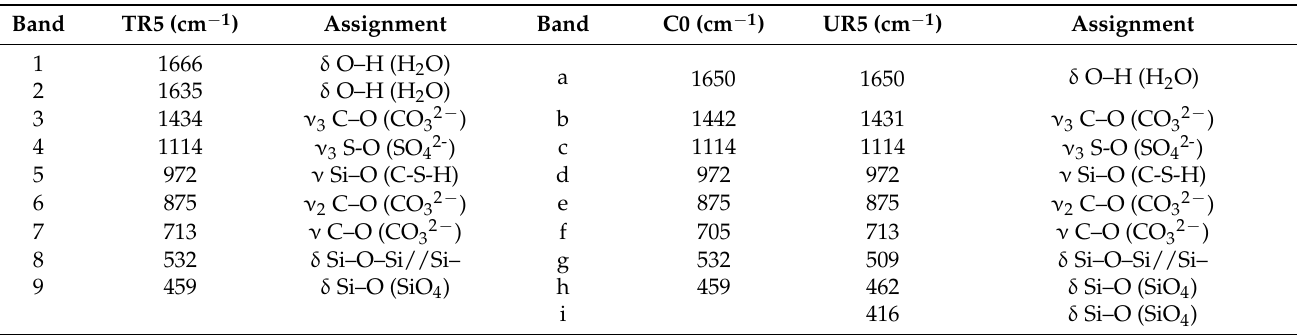
Figure 9. FT-R spectra of the cement pastes: C0 (black line); UR5 (red line); and TR5 (blue line). Table 2. C0, UR5, and TR5 band assignments of FT-IR.